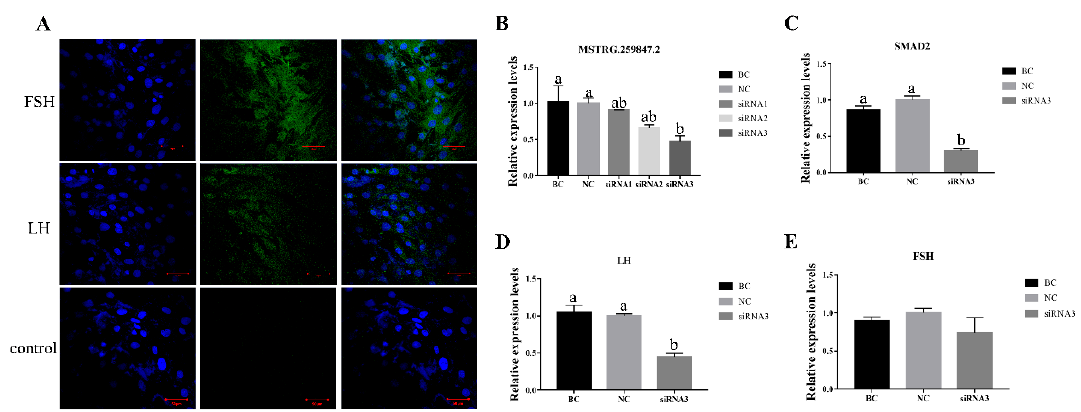
Figure 8. ( A ) Identification of sheep pituitary cells by FSH and LH immunofluorescence staining. The left panels DAPI staining for nucleus, middle panels show antigen-specific staining and the right panels show their merged images. Bars indicate 50 µ m. ( B ) The relative expression levels of lncRNA MSTRG.259847.2 in sheep pituitary cell transfecting with MSTRG.259847.2 siRNA 1, 2 and 3. ( C ) The relative expression of SMAD2 (lncRNA MSTRG.259847.2 target gene) in sheep pituitary cell transfecting with MSTRG.259847.2 siRNA3. BC and NC represent blank and negative controls, respectively. Results are expressed relative to the BC group as mean values ± the SEM. a, b: different letters denote statistically significant differences within each group. ( D , E ) The relative expression of LH and FSH in transfected pituitary cells was determined using qPCR. The relative expression levels were normalized to the expression levels of GAPDH . Results are expressed relative to the blank control mean values ± SEM. a, b, c: different letters denote statistically significant differences within each group; p < 0.05.